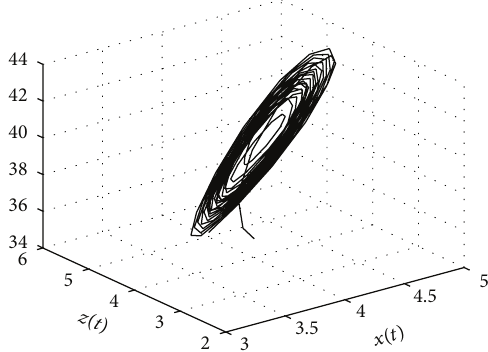
Figure 12: For system (97), an unstable periodic solution bifurcates from the steady state 𝑆 + when 𝑘 1 = −3 , 𝜏 = 1.5 .